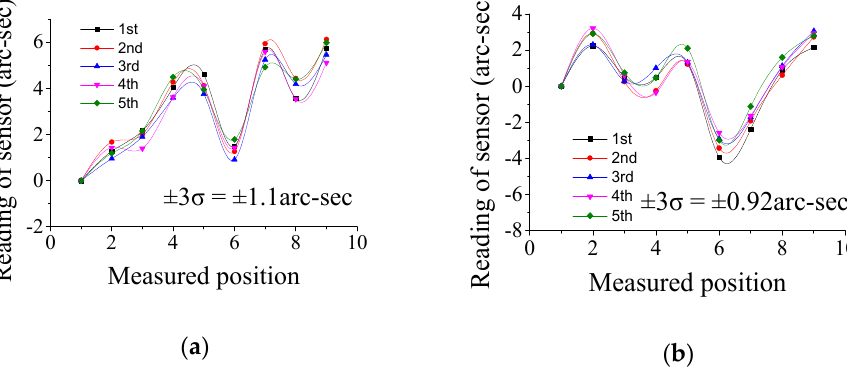
Figure 9. Measurement repeatability: ( a ) ε x ; ( b ) ε y .